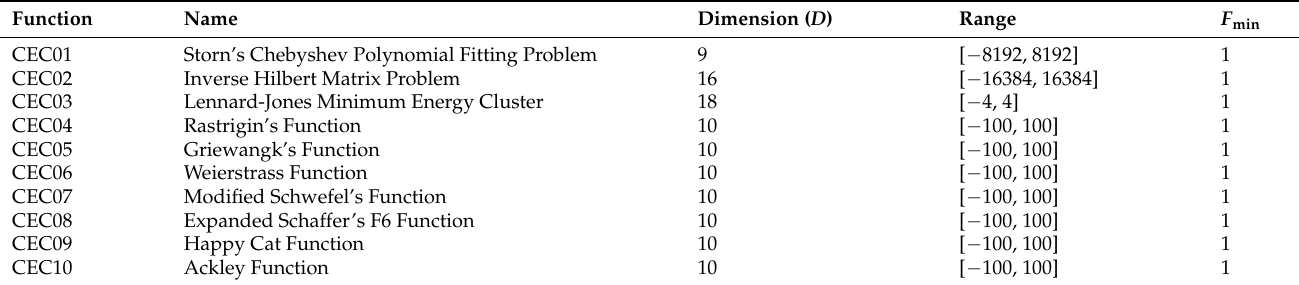
Table 10. IEEE CEC2019 test